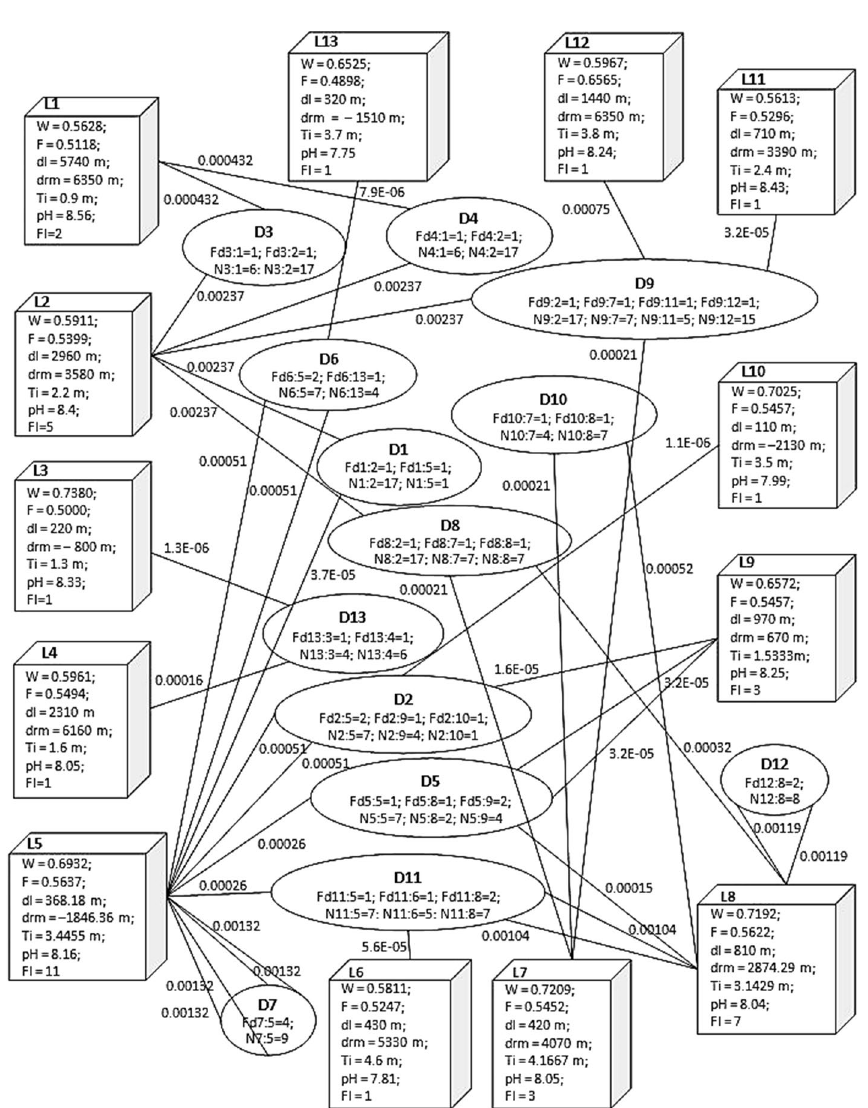
Fig. 10 BiHSN with parameter values for location nodes, dolphin nodes and the link weights (Source: Liew et al. 2015a, p.